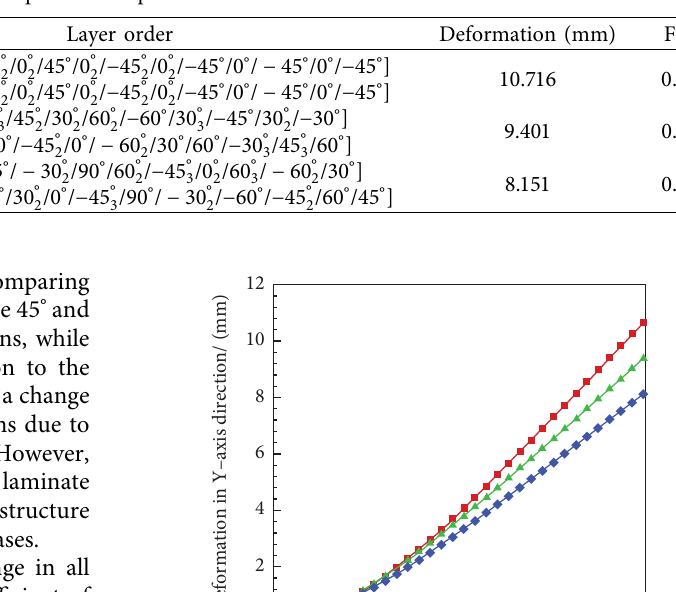
Table 4: Comparison of optimization schemes.